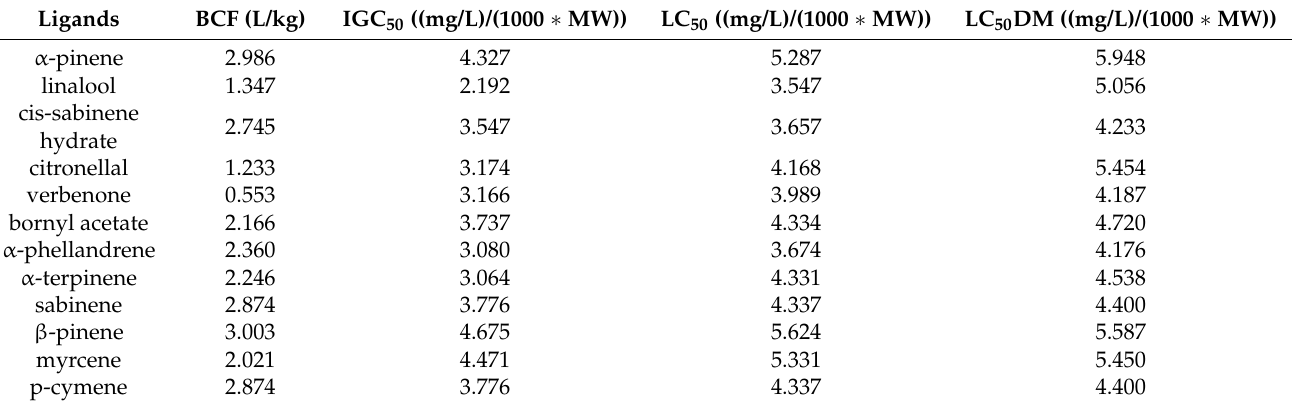
Table 8. In-silico environmental toxicity profile of the selected ligands.